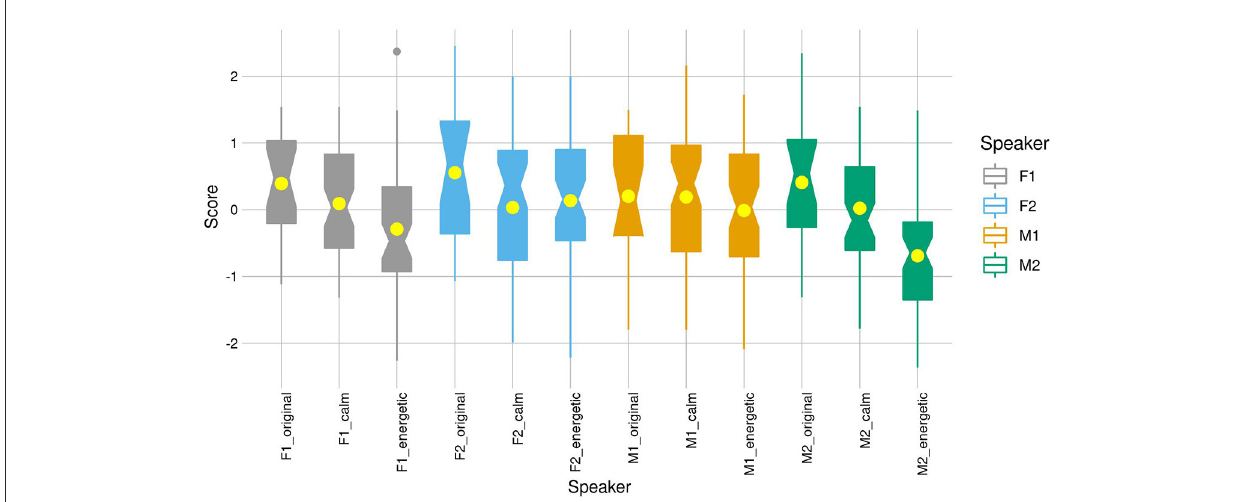
FIGURE2 The normalized likability scores for the original synthesized speech and the style-transferred calm and energetic advertising styles for each voice separately.